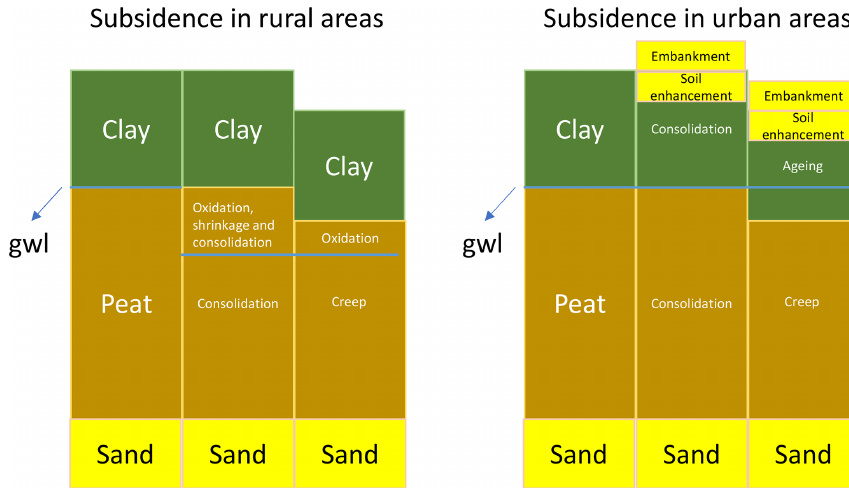
Figure 1. Visualisation of the processes of autonomous subsidence in rural and urban areas with clay